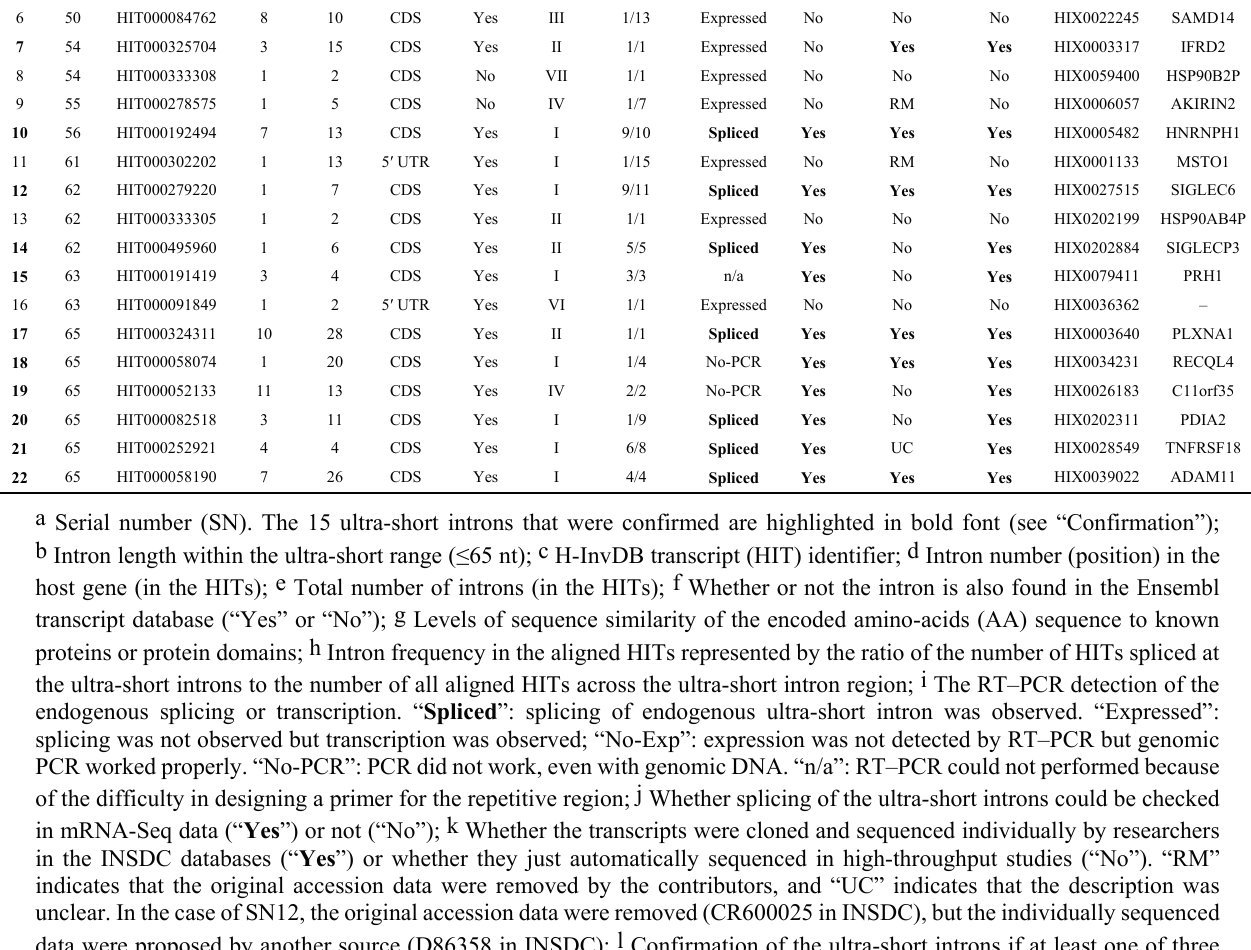
Table 1. Candidate of human introns ( ≤ 65 nt) conserved in both genome and transcriptome sequences. Length SN a (nt) b